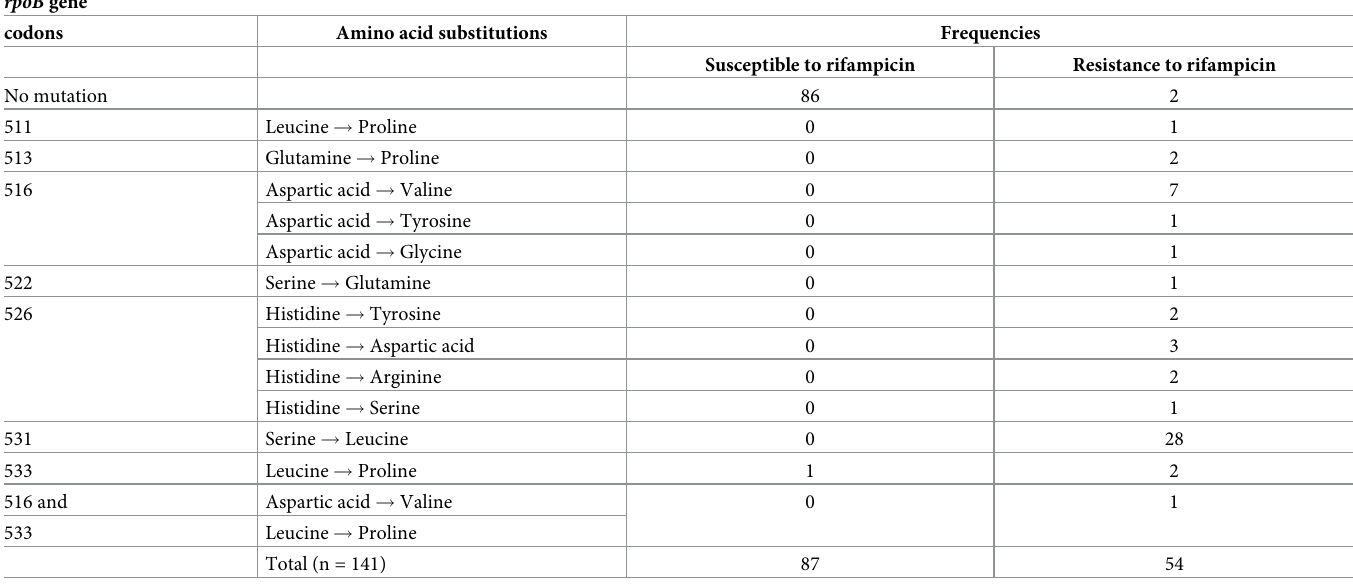
Table 4. Frequency of amino acid substitutions within 81-base-pair hotspot region of the rpoB gene of 141 M . tuberculosis . rpoB gene